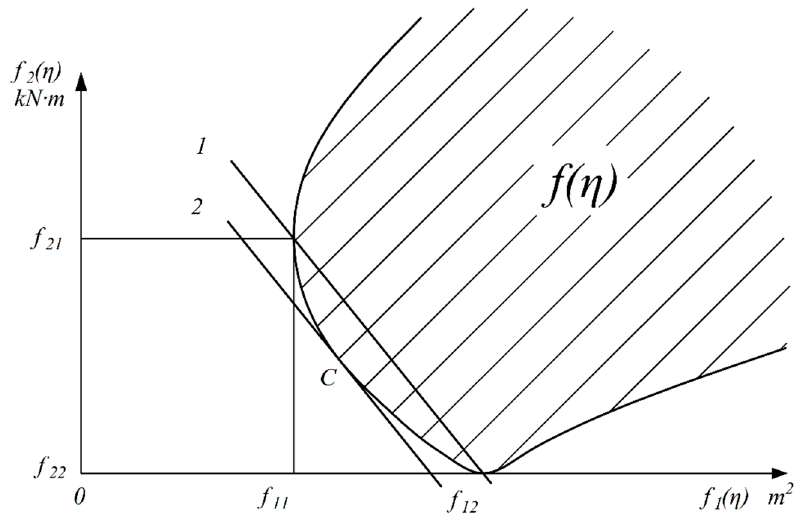
Figure 6. Schematic diagram of the α method for determining weights.